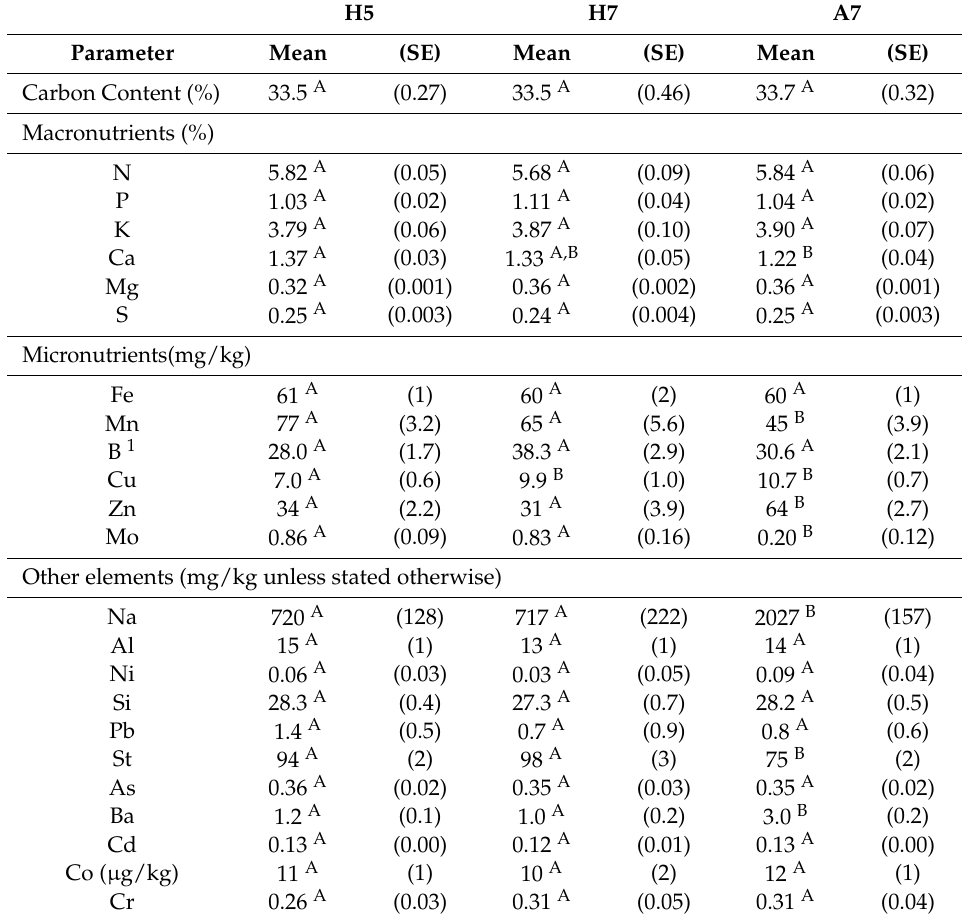
Table 10. Shoot elemental analysis using ICP-AES by treatment for mean, standard error (SE), and significance 1 among treatments; all data is on dry weight basis and in mg/kg unless otherwise